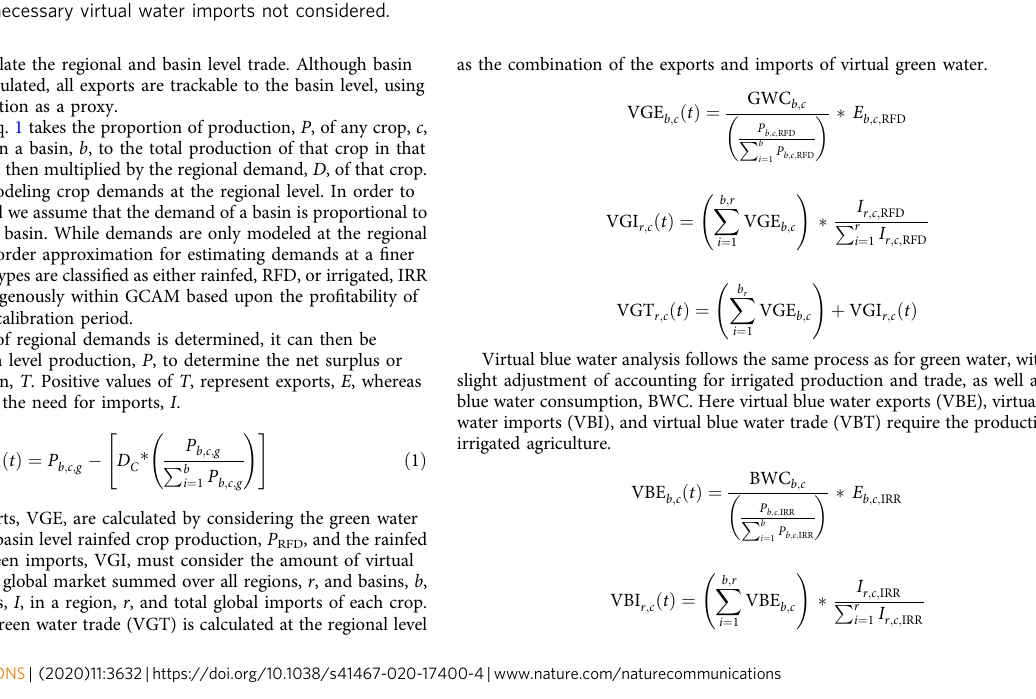
Fig. 3 Basin-level virtual water exports in 2050 and 2100 for all sectors. Virtual green water exports (billion m 3 ) a and b , and blue water exports (billion m 3 ), c , d in 2050 and 2100 respectively for the average of fi ve GCM runs for SSP2-RCP6.0. Virtual nonrenewable groundwater exports (billion m 3 ) in 2050 and 2100 for the same averaged GCM runs for SSP2-RCP.6.0 is shown in e and f . All values are considering the exports of agricultural crops only with additional, potentially necessary virtual water imports not